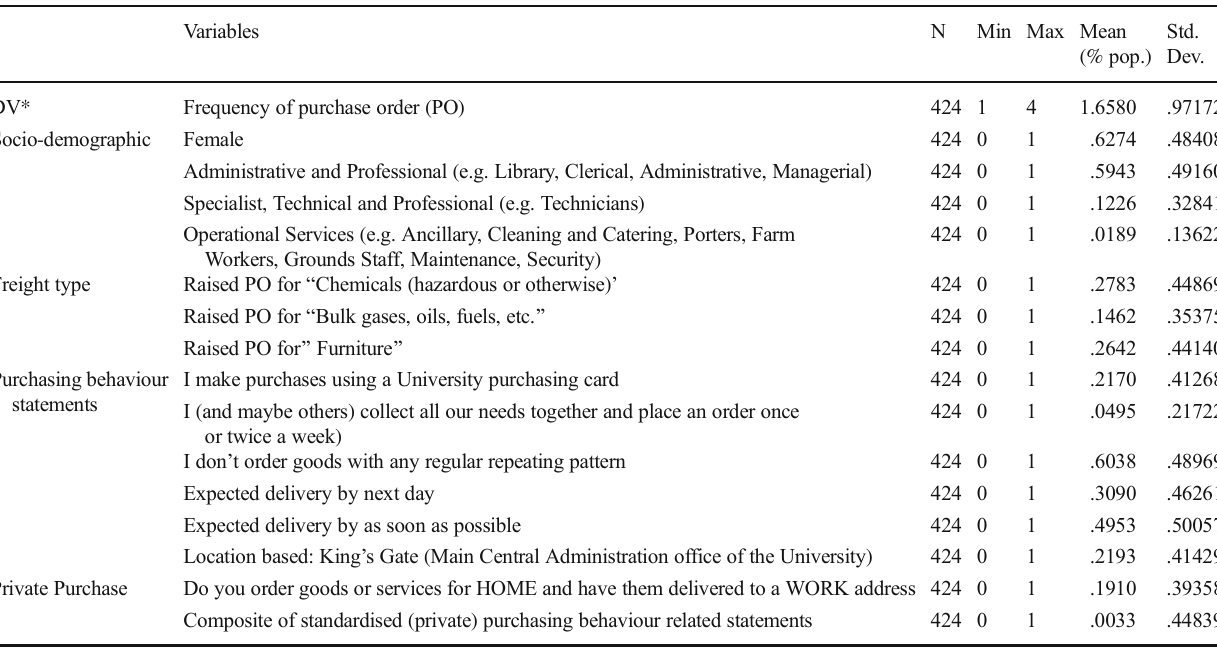
Variables ’ descriptive statistics included in the final regression